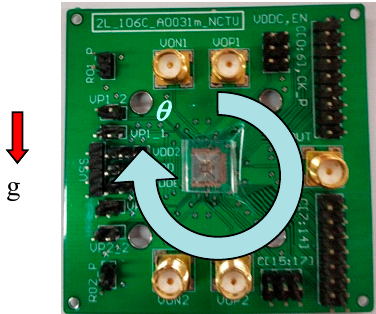
Figure 10. CMOS-MEMS accelerometer die mounted on a printed circuit board (PCB) for electrical testing.